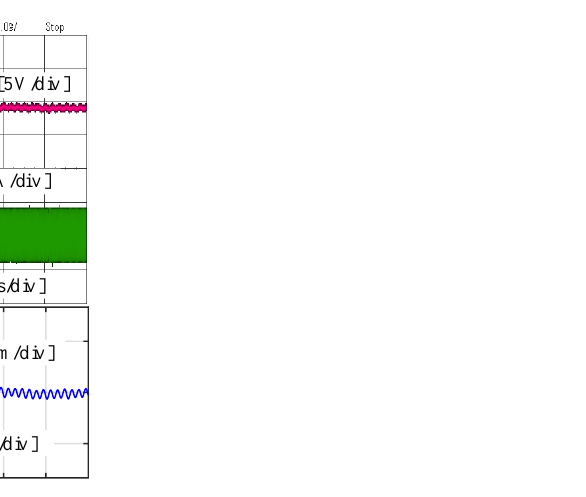
Figure 17. Transient waveform of the system at K = 0.5, P o step change from 2.5 W to 5 W for constant DC-link voltage strategy.